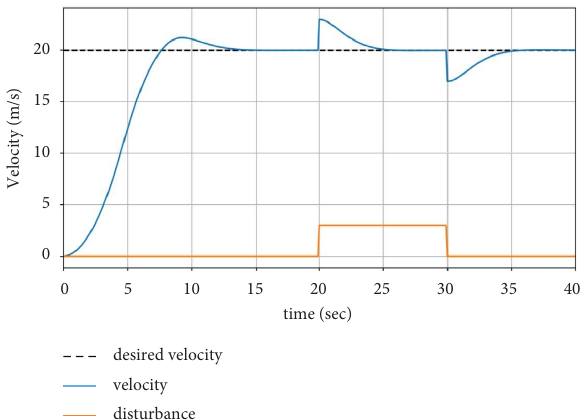
Figure 8: Tracking desired velocity in the presence of external disturbance.